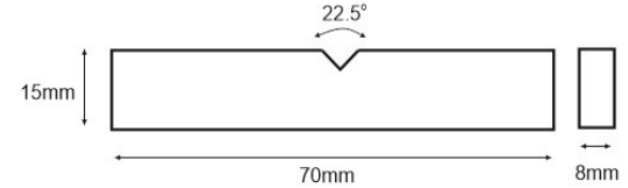
Figure 6. Dimension of impact test specimen.